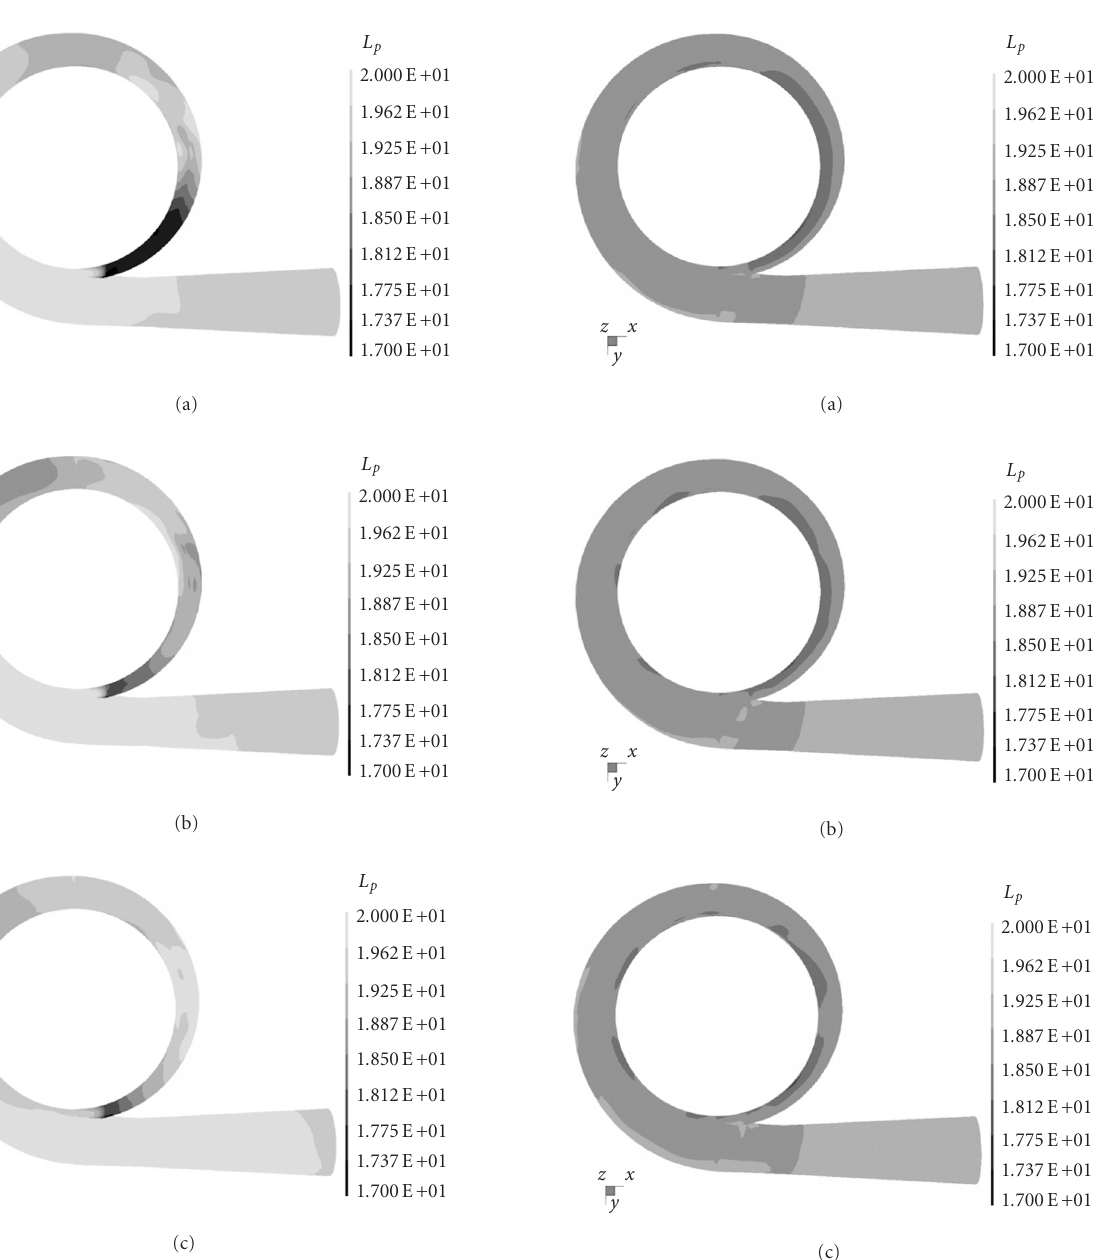
Figure 22: Static pressure on the volute surface for the vaned case at near-surge conditions: (a) starting position, (b) 1 / 3 revolution, and (c) 2 / 3